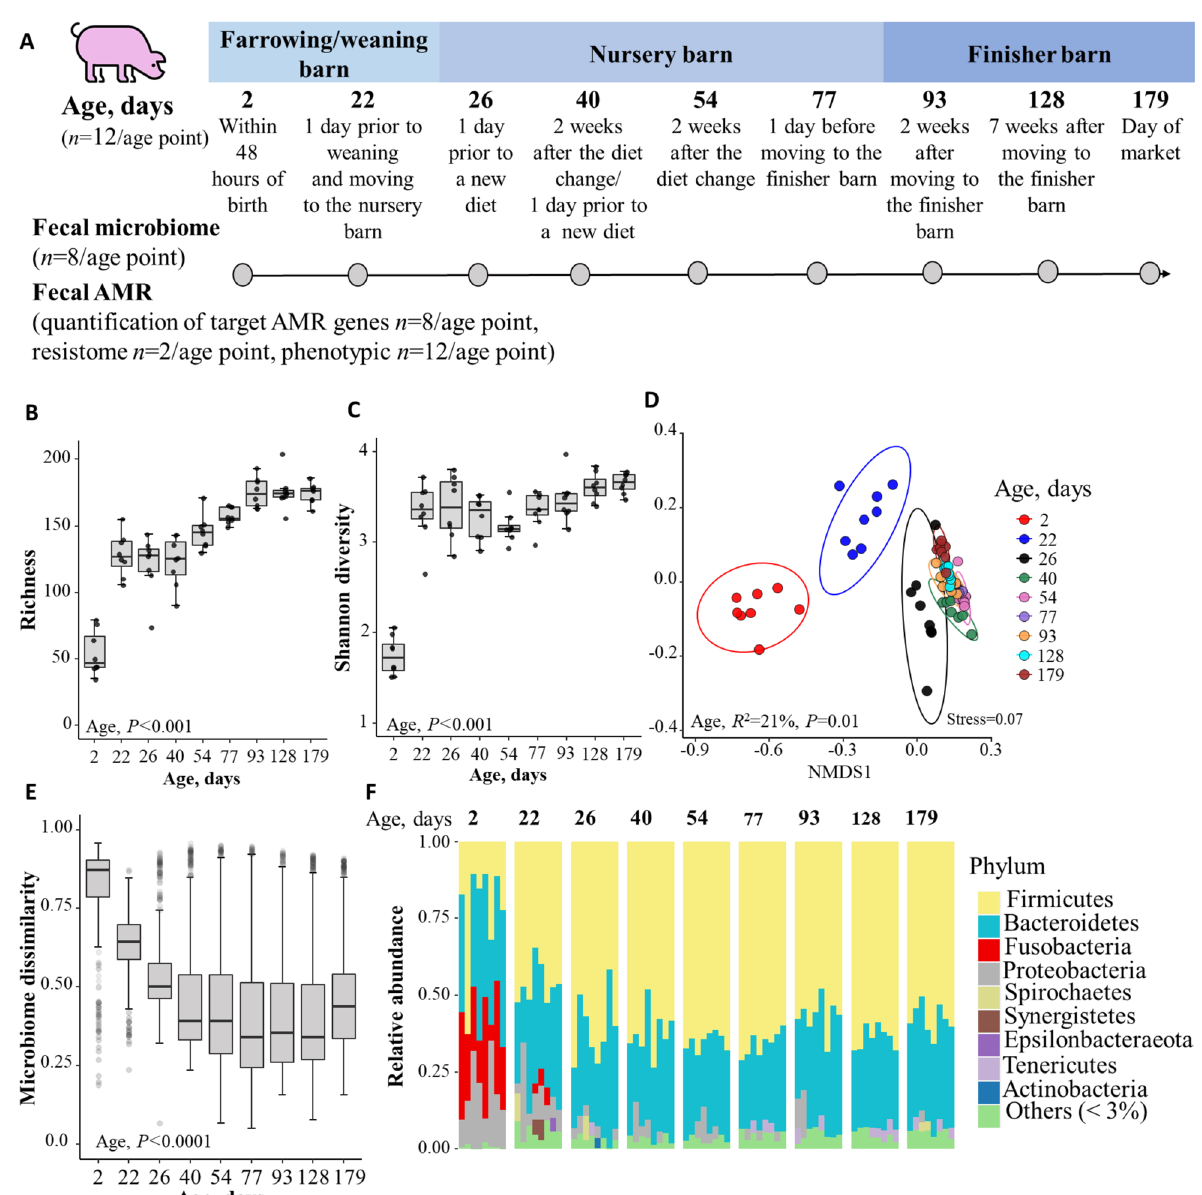
Fig. 1 Dynamics of fecal microbiome in a cohort of pigs (2 days of age to market age). A The number of pigs, housing, and sampling of feces of pigs for microbiome and resistome analyses. B , C Longitudinal development of Alpha diversity (at the genus level) measured by richness and Shannon diversity. D Non-metric multidimensional scaling (NMDS) ordinating plot based on Bray–Curtis distances illustrate the variation in microbial community structures (i.e. beta diversity; R 2 represents the amount of variability explained by age and associated P values based on PERMANOVA analysis), ellipses represent 95% confidence intervals for each age point. E Fecal microbiome community dissimilarity (Bray–Curtis dissimilarity index value) among age-points. F Stacked bar representing relative abundance of phyla over time; phyla with relative abundances less than 3% were grouped into “Others <